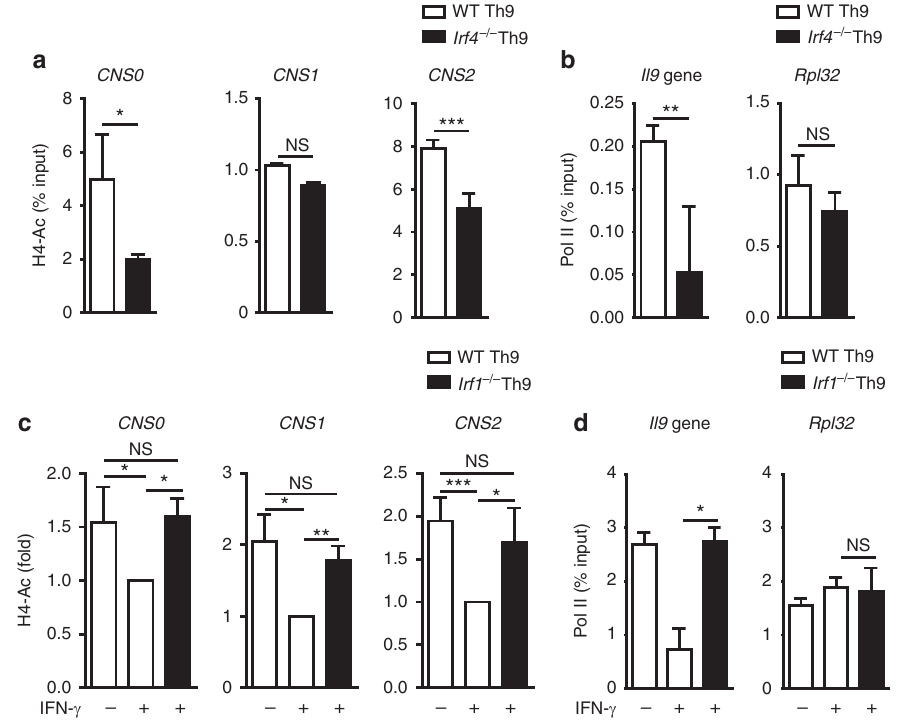
Figure 3 | Opposite effects of IRF1 and IRF4 on histone acetylation at Il9 locus. ( a – d ) Purified WTand ( a , b ) Irf4 (cid:2) / (cid:2) or ( c , d ) Irf1 (cid:2) / (cid:2) CD4 þ Tcells were cultured under Th9 conditions with or without IFN- g . ( a , c ) ChIP analysis of histone H4 acetylation (Ac) at CNS of the Il9 gene. ( c ) Bars show fold induction of H4-Ac relative to WT Th9 cells treated with IFN- g . ( b , d ) ChIP analysis for RNA polymerase II (pol II) occupancy at Il9 and Rpl32 genes. ( a – d ) The same chromatin was used for control ChIP experiments with control IgG. Precipitated DNA is presented relative to input (% input). Values for nonspecific binding